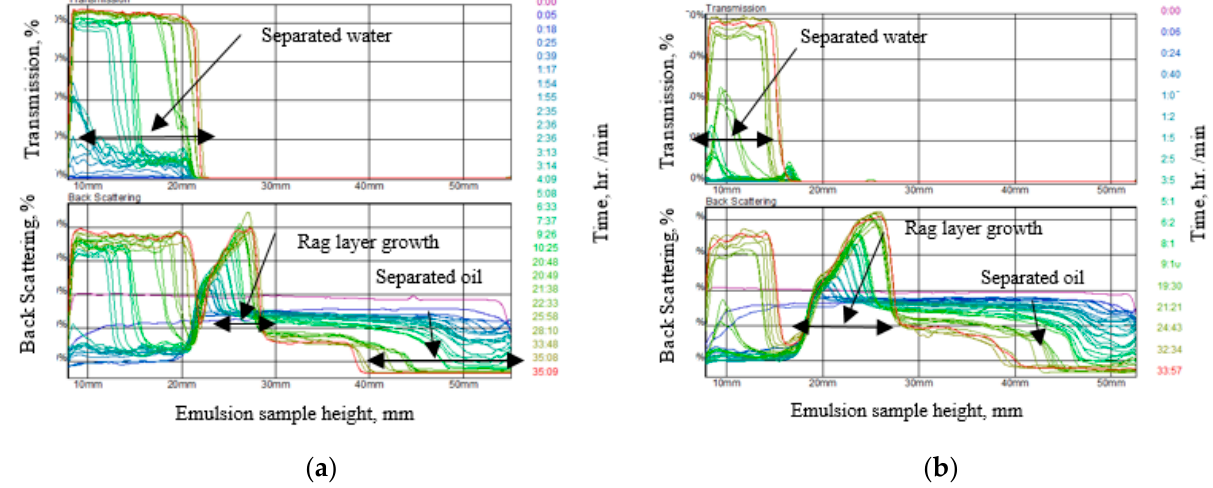
Figure 9. Emulsion as a function of the surfactant. ( a ) Low surfactant; ASP (ppm) = 1000, 200, 600. ( b ) High surfactant; ASP (ppm) = 1000, 600, 600. The dark and light blue color lines shows the initial measurement of emulsion stability values; red & yellow color lines shows final stability measurement values.